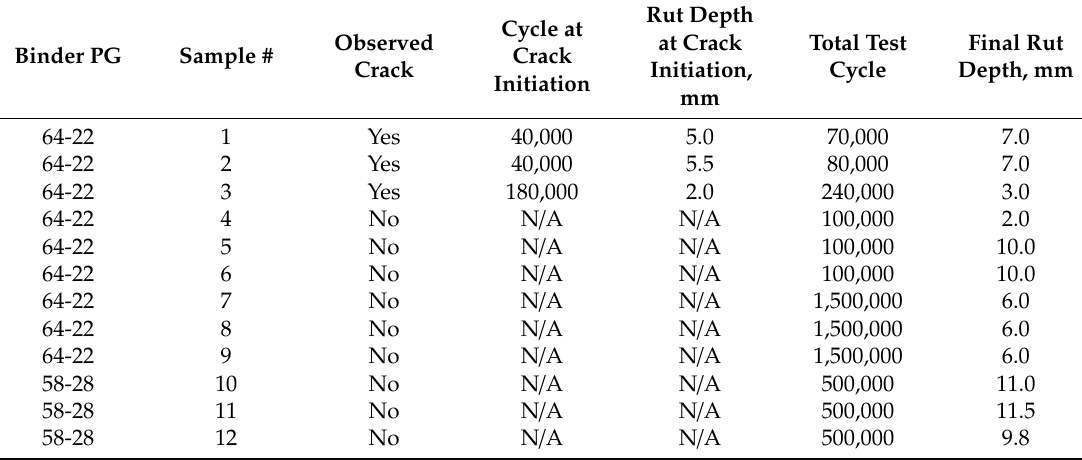
Table 3. Summary of crack initiation cycles and rut